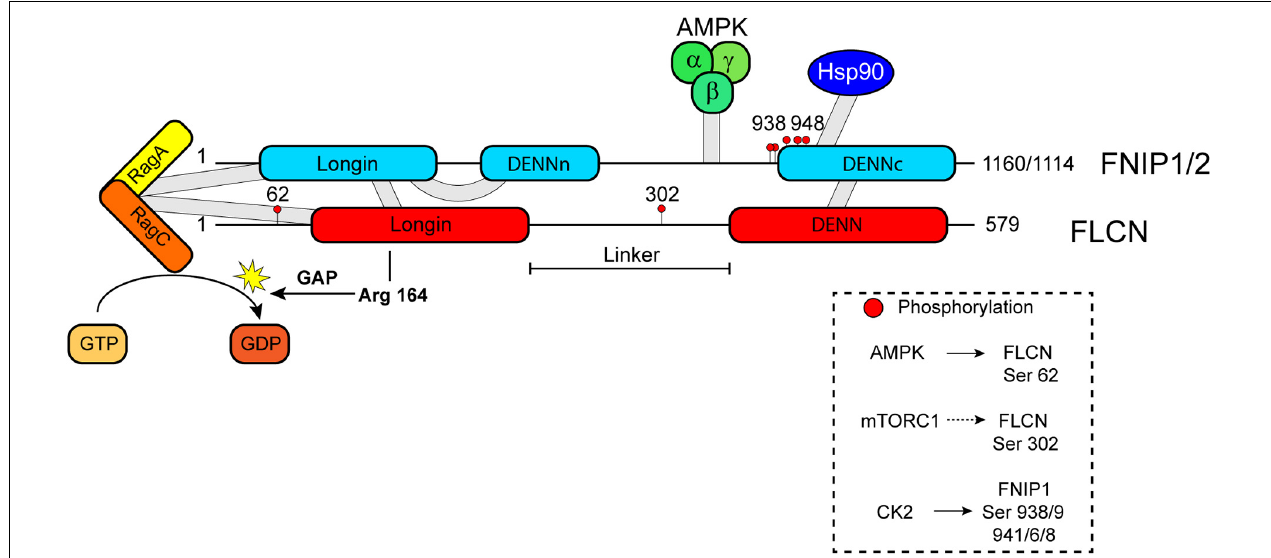
FIGURE 1 | Schematic diagram of FLCN and FNIP domains and their interacting partners AMPK, Hsp90, and Rag A/C. FLCN GAP activity on Rag C is indicated as well as the catalytic arginine finger Arg 164. Phosphorylation sites within FLCN and FNIP sequences are marked by red-filled cycles and putative (dashed arrow) or known kinases (continuous arrow) are indicated in the